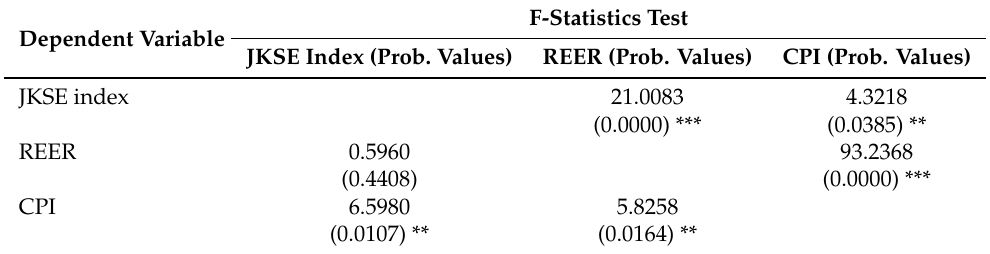
Table 2. Pairwise Granger causality test of the normalized return series of Indonesia. Dependent Variable